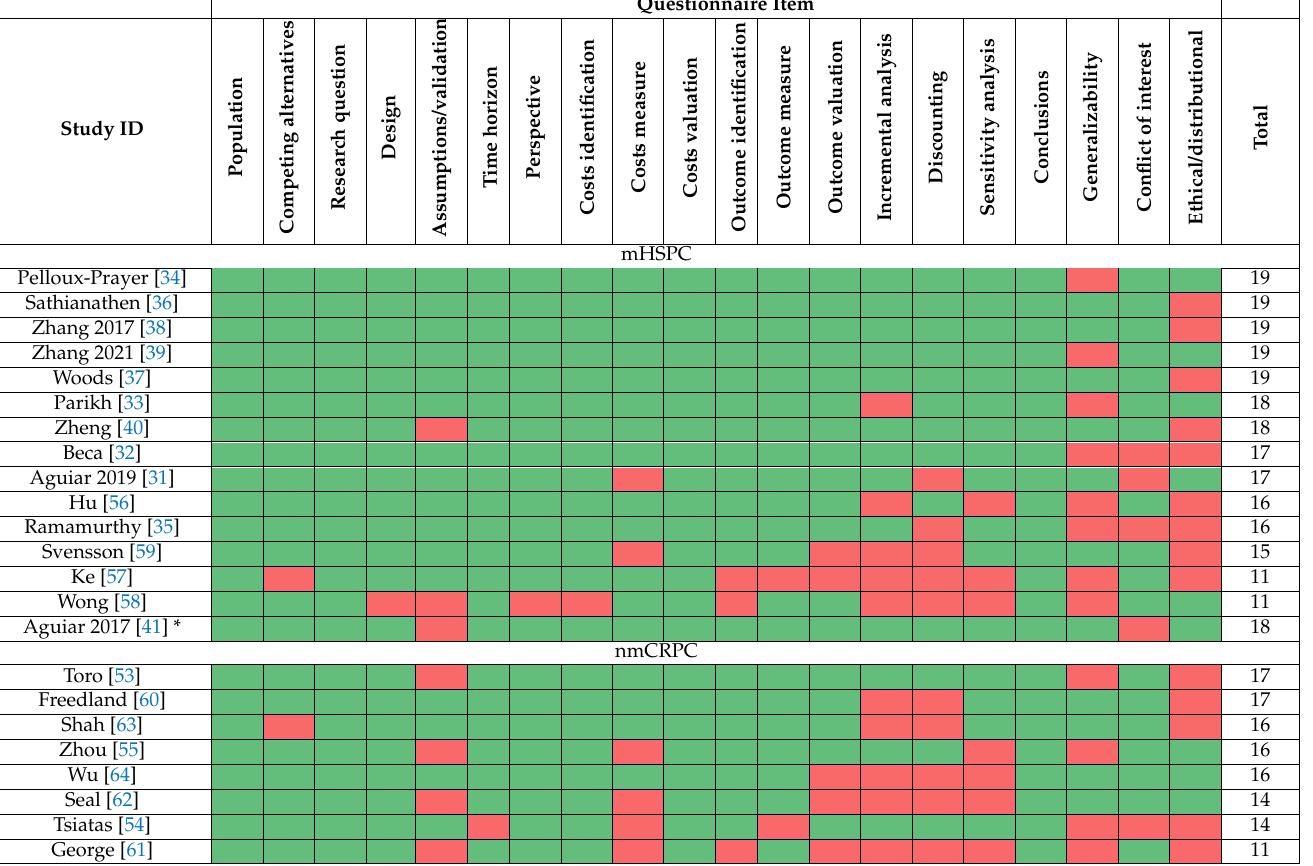
Table 4. Quality assessment of selected mHSPC and nmCRPC